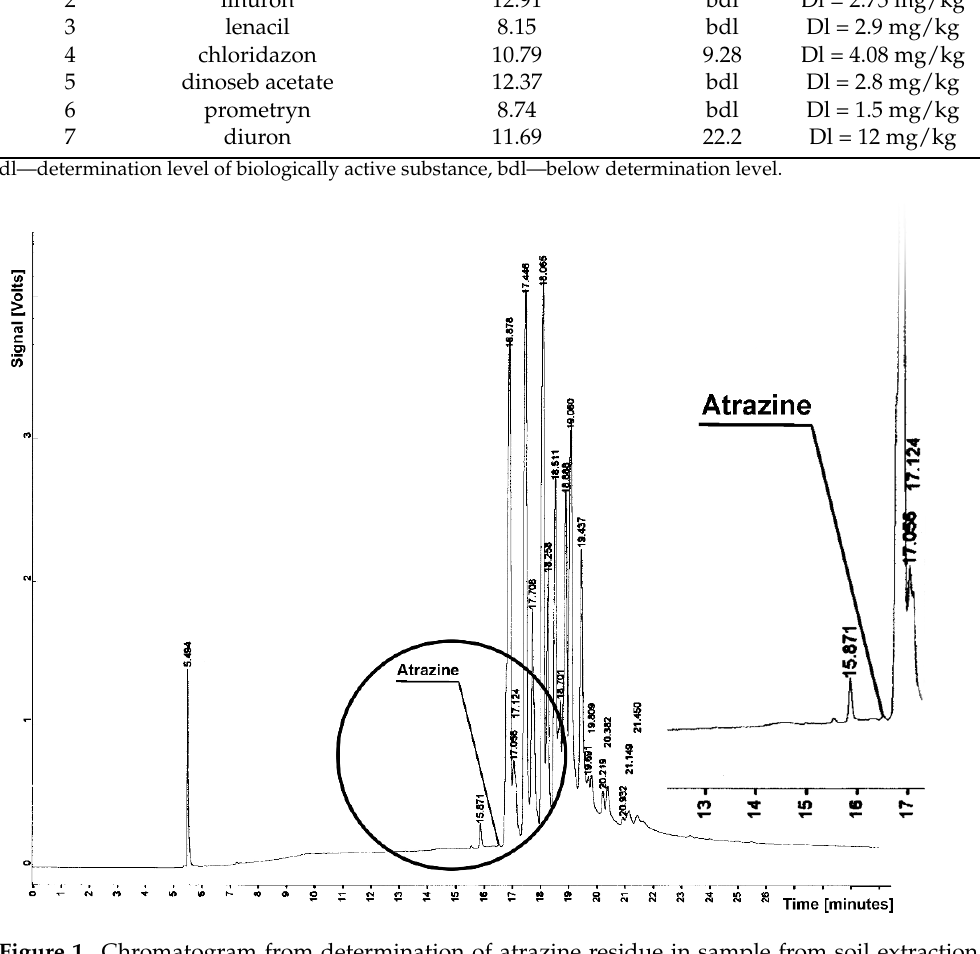
Figure 2. Chromatogram from determination of linuron residue in sample from soil extraction; tR = 16.072—linuron. Figures 1 and 2 present chromatograms from the determination of in the sample at- razine and linuron. These substances elute from the column before soil components, for